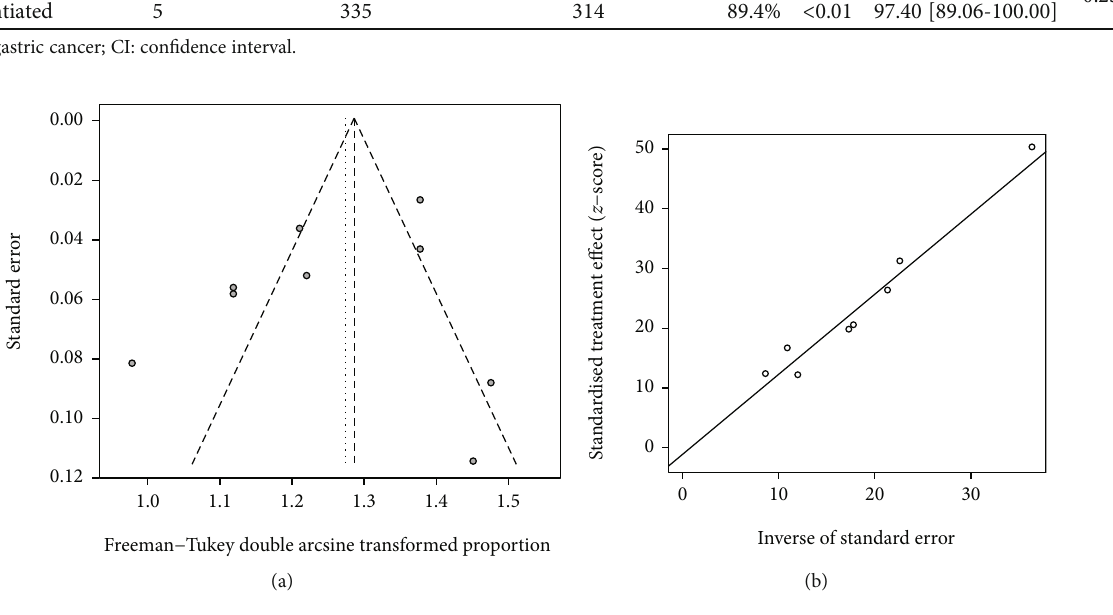
Figure 4: The funnel plot and Egger ’ s regression test for publication bias. (a) The funnel plot for publication bias. (b) Egger ’ s regression test for publication